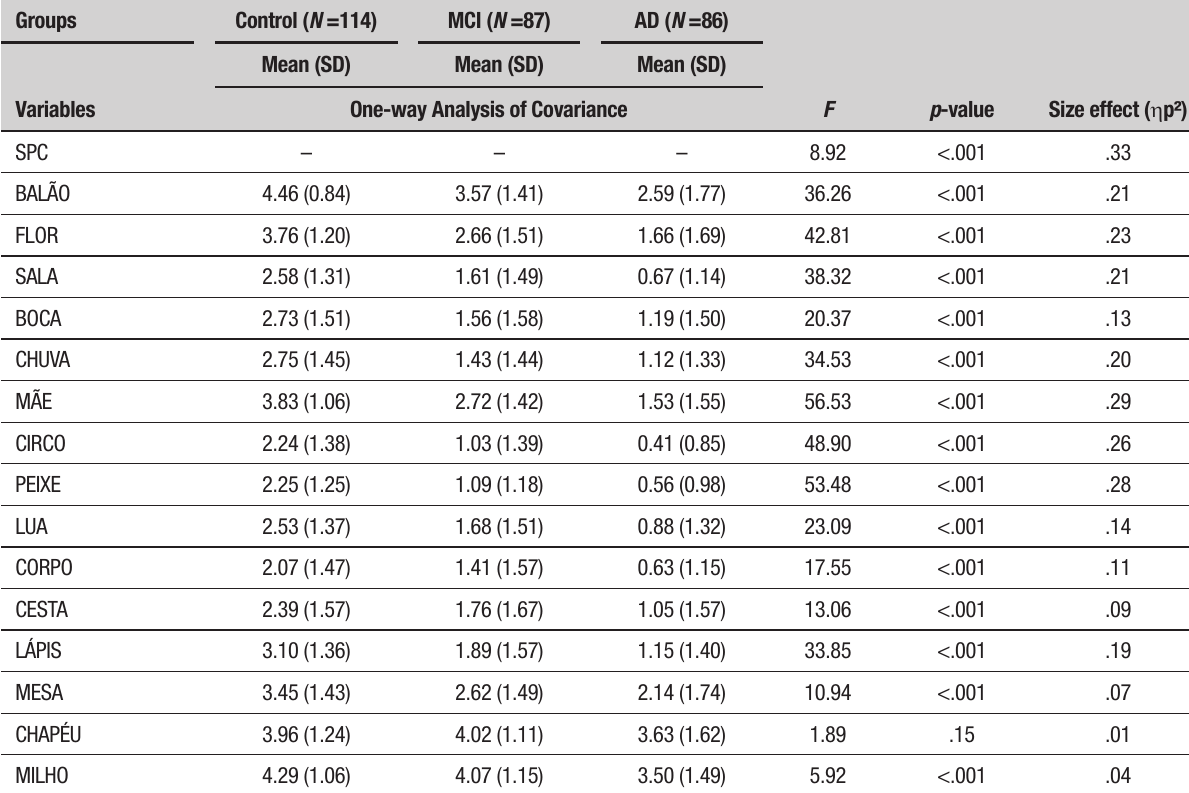
Table 3. MANCOVA and ANCOVA results for group effects in the serial position curve and in each word from the list.